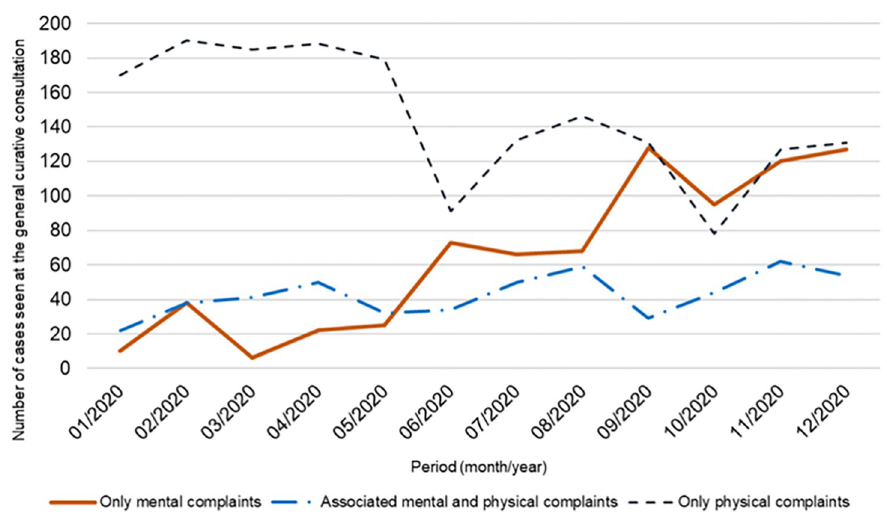
https://doi.org/10.1371/journal.pone.0280089.g001